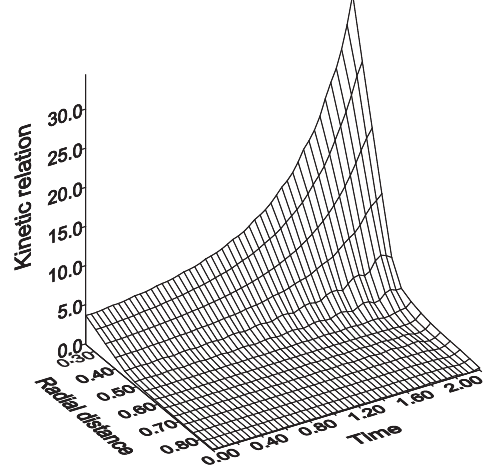
L − ( 1 / 4 )( L + 11 22 12